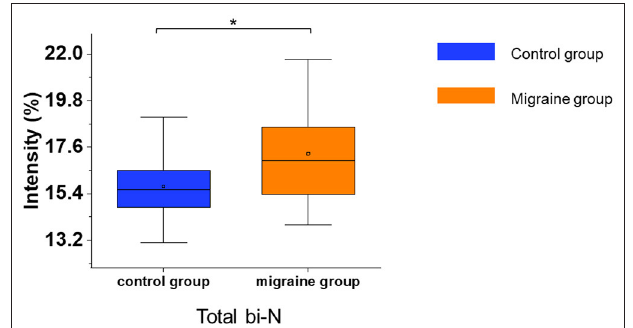
FIGURE 5 | The serum level of IgG N-glycosylation in the migraine ( n = 20) and control groups ( n = 20). The serum level of IgG N-glycosylation was presented as box plots showing median values, upper and lower quartiles, as well as the whole range for patients and controls. bi-N, bisecting N-acetylglucosamine. * p < 0.05.